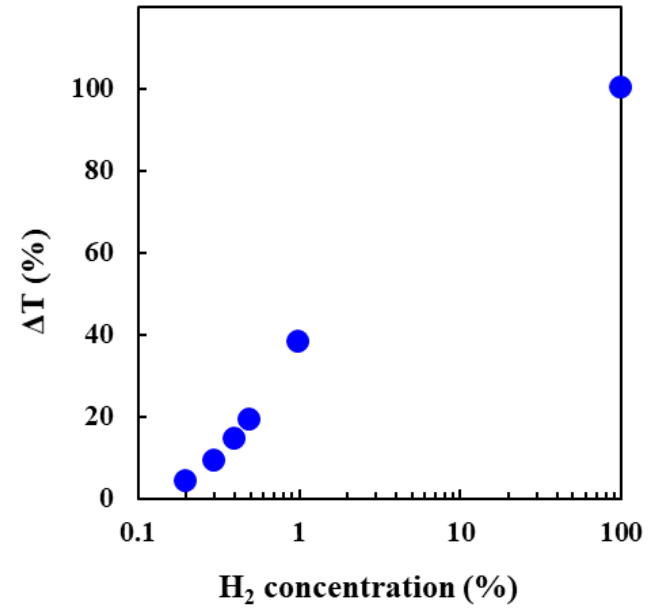
Figure 6. H 2 gas detection performance of the Pt/WO 3 composite membrane. (Pt:W = 1:13; heat treatment at 573 K; particle concentration of 0.75 wt.%; measurement wavelength of 800 nm; exposure to H 2 gas concentrations of 0.1–100